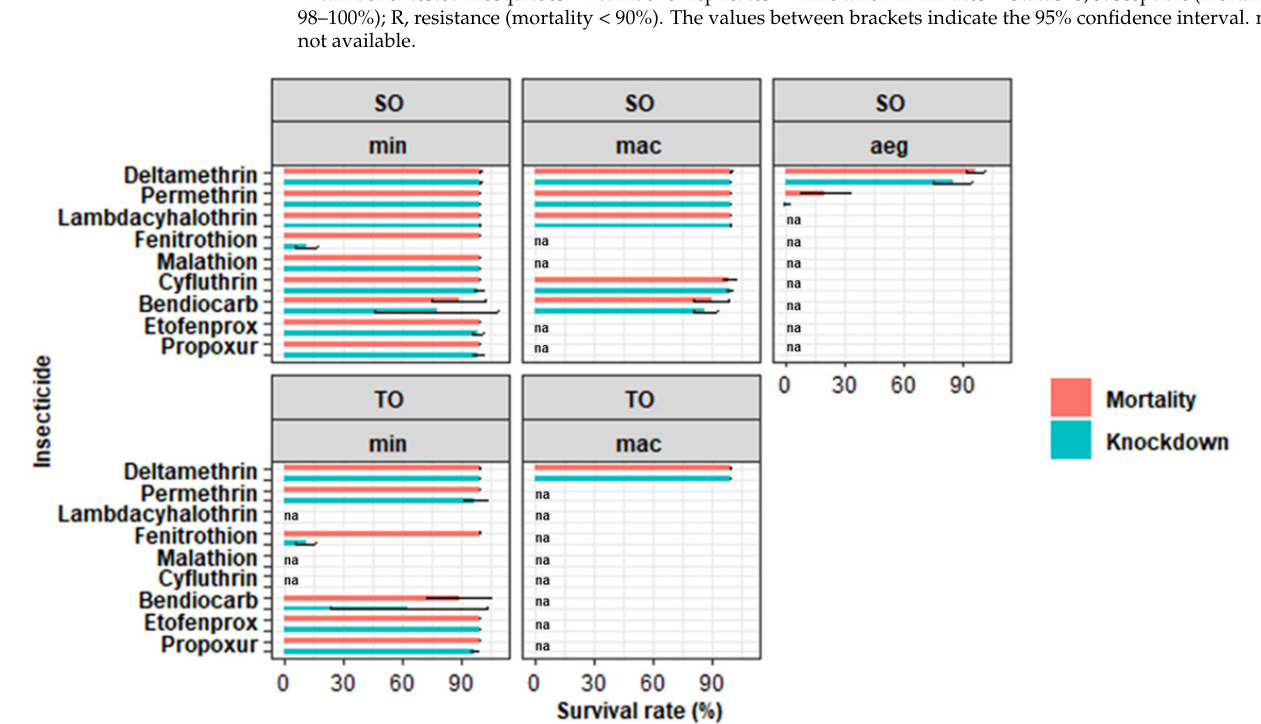
Table 2. Summary results of WHO bioassay tested in An. minimus s.l. and An. maculatus s.l. in Tala Oka (TO).